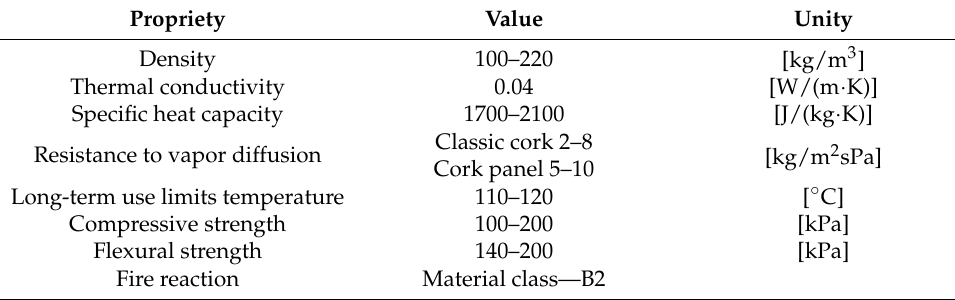
Table 1. Physical characteristics of commercial cork for building applications [33].